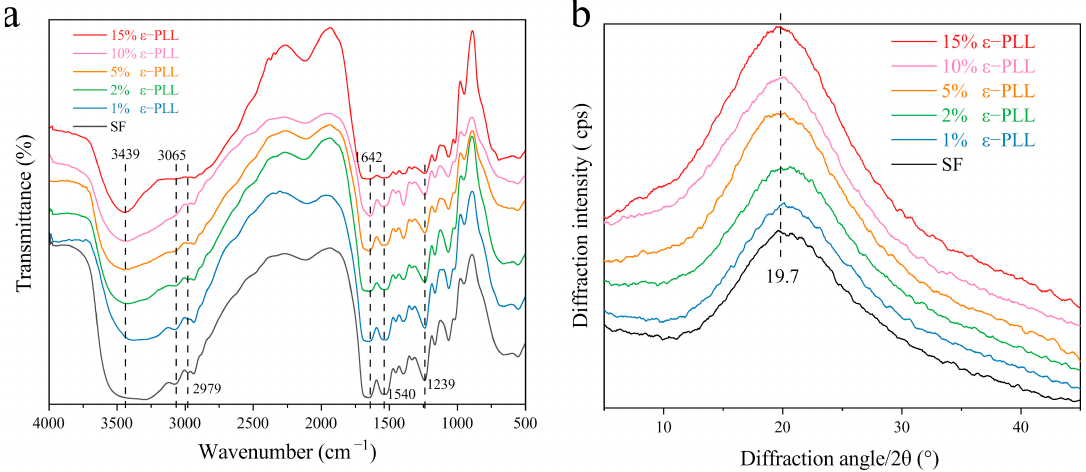
Figure 4. Structure of CSF: ( a ) Infrared spectrum; ( b ) X-ray diffraction curve. It can be seen from Figure 4b that pure SF is mainly a random coil structure, with a large wide diffraction peak at 20.7° and a small diffraction peak at 9.1°, indicating a